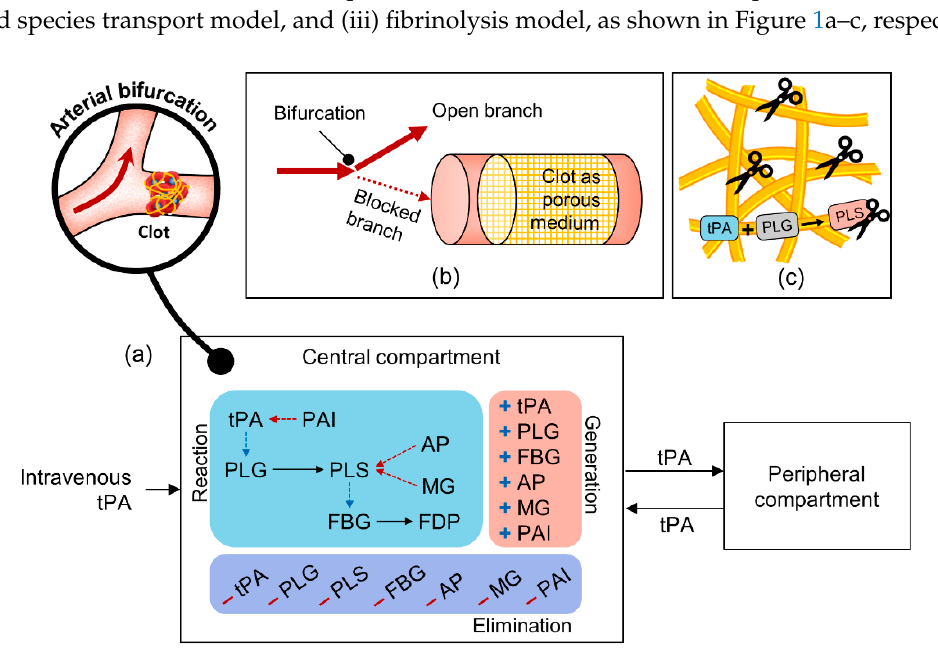
Figure 1. Overview of the full mathematical model. ( a ) Two-compartment model for pharmacokinetics and pharmacodynamics (PKPD) of tissue plasminogen activator (tPA) in the body (or the “systemic PKPD model”), ( b ) one-dimensional (1D) blood flow and species transport in an occluded artery, and ( c ) fibrinolysis described by binding of fibrinolytic proteins with fibrin fibres and the cleavage of fibrin network by bound plasmin. Coupled 1D blood flow and transport and fibrinolysis are referred to as the “local PD model”.